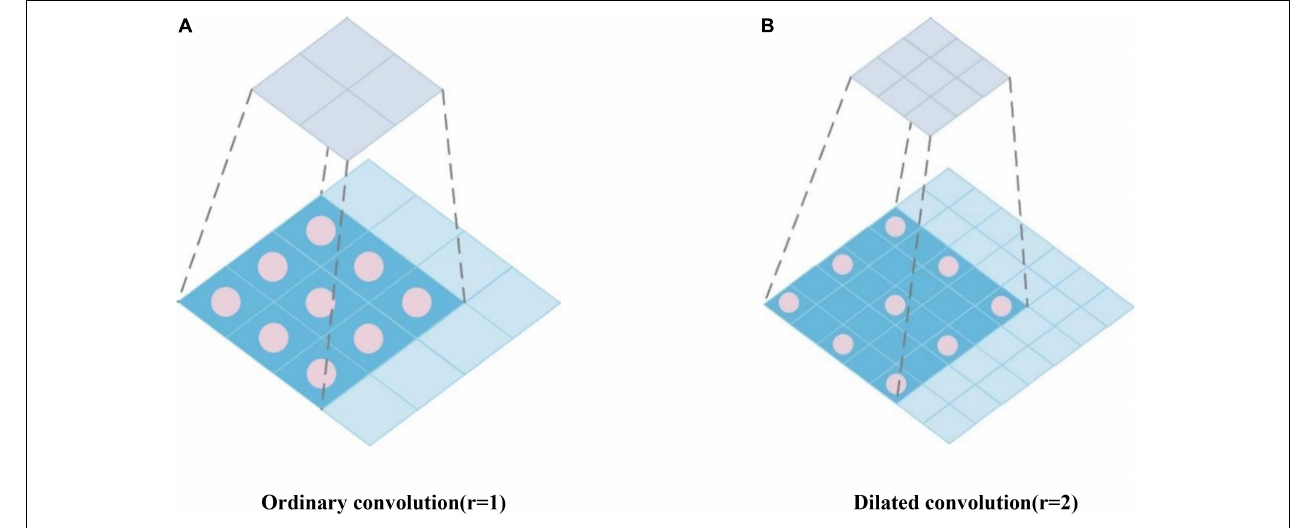
FIGURE 7 | Perceptual field of ordinary convolution and extended